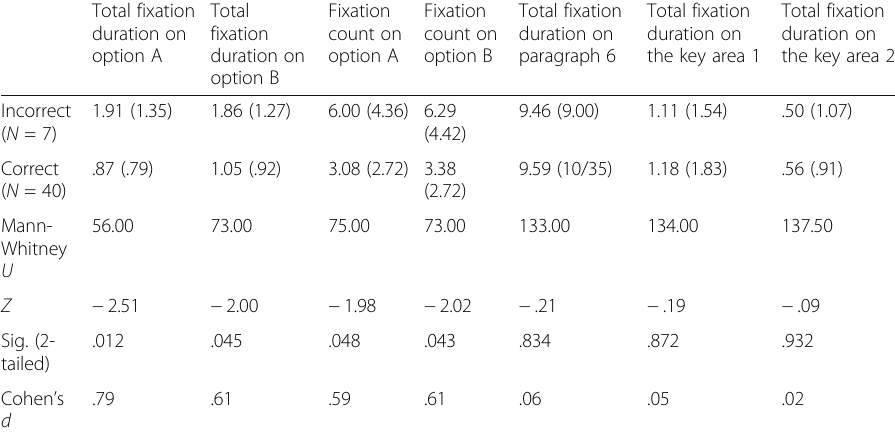
Table 8 Eye-tracking statistics for item